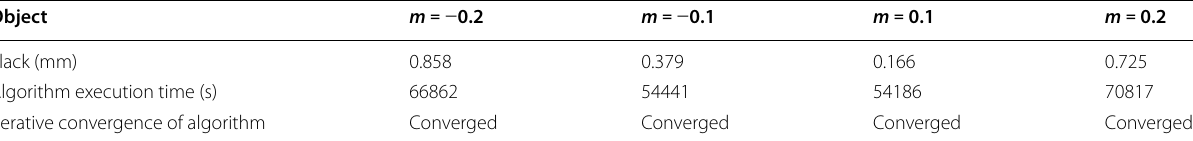
Table 1 Comparison of related objects of automatic optimization algorithm under different transmission ratio laws Object